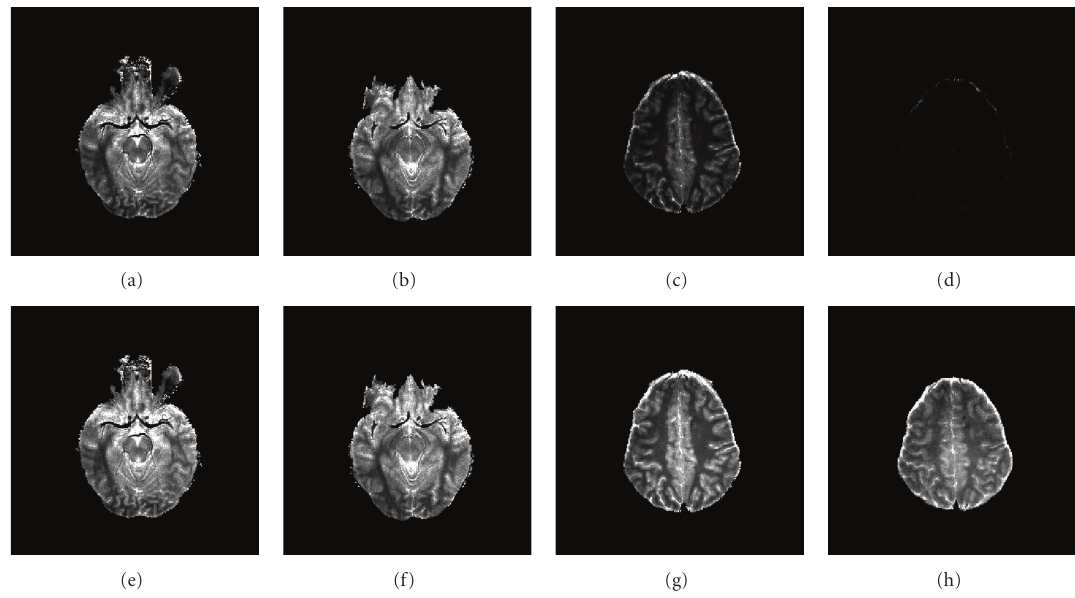
Figure 10: T 1 -Maps generated from unrectified (First row) and rectified (second row) flip angle images at slice number 5, 6, 14 and 15.